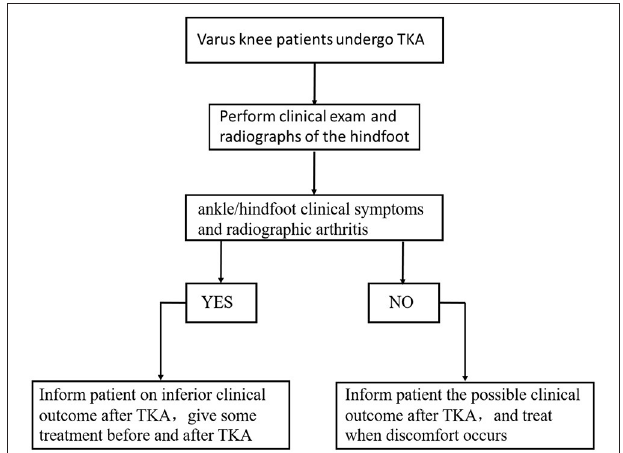
FIGURE 2 | Flowchart in patients undergoing